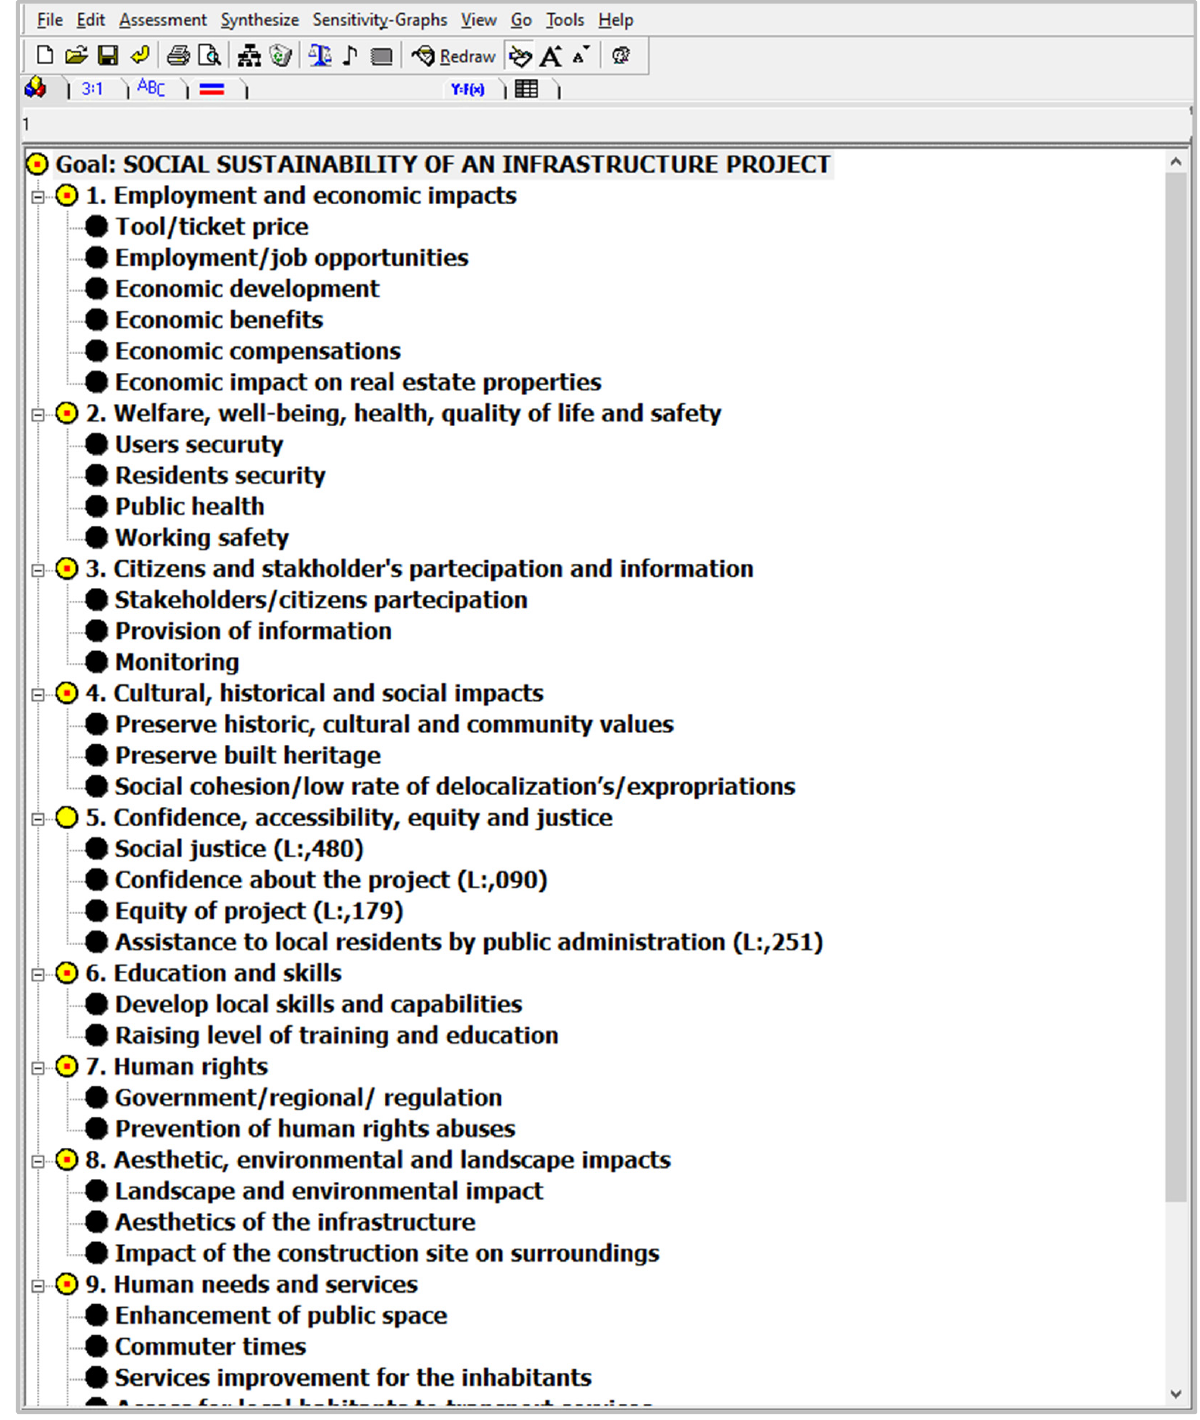
Figure 5. Expert Choice 2000 ® —hierarchical structure of categories and criteria.